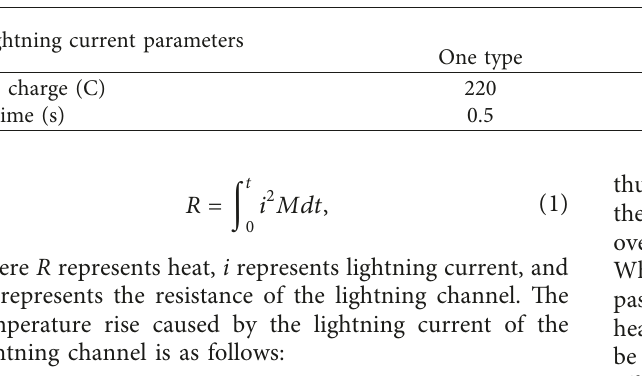
Table 3: Lightning current amplitude of long-term lightning strike.